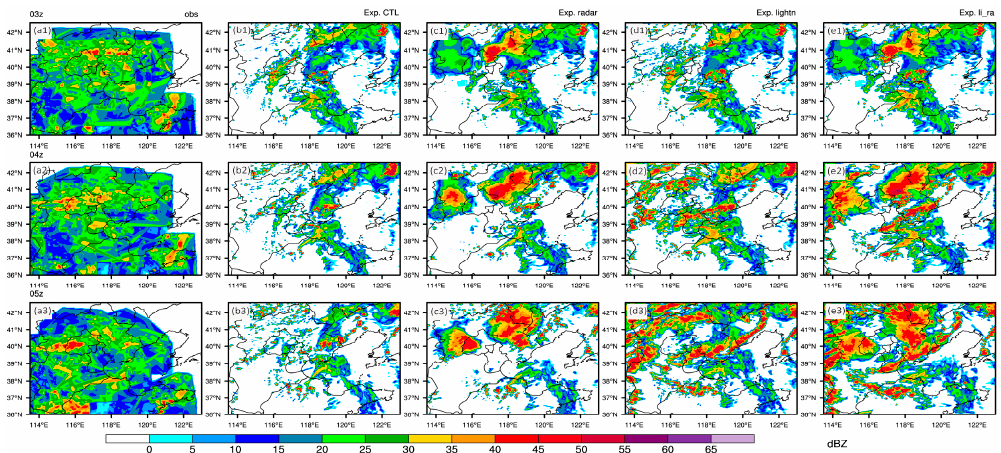
Figure 6. Ten minute forecast maximum reflectivity (dBZ) of the four experiments from 0300 UTC to 0500 UTC. Panels ( a1 – a3 ) show observed maximum reflectivity from the six Doppler radars at Beijing, Tianjin, Shijiazhuang, Qinghuangdao, Jinan and Qingdao, and panels ( b – e ) show the maximum reflectivity of Exp. CTL, Exp. radar, Exp. lightn and Exp. li_raat each of these 3 h, respectively (unit: dBZ).